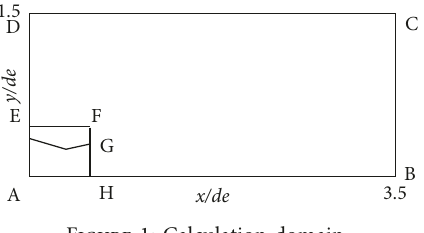
Figure 1: Calculation